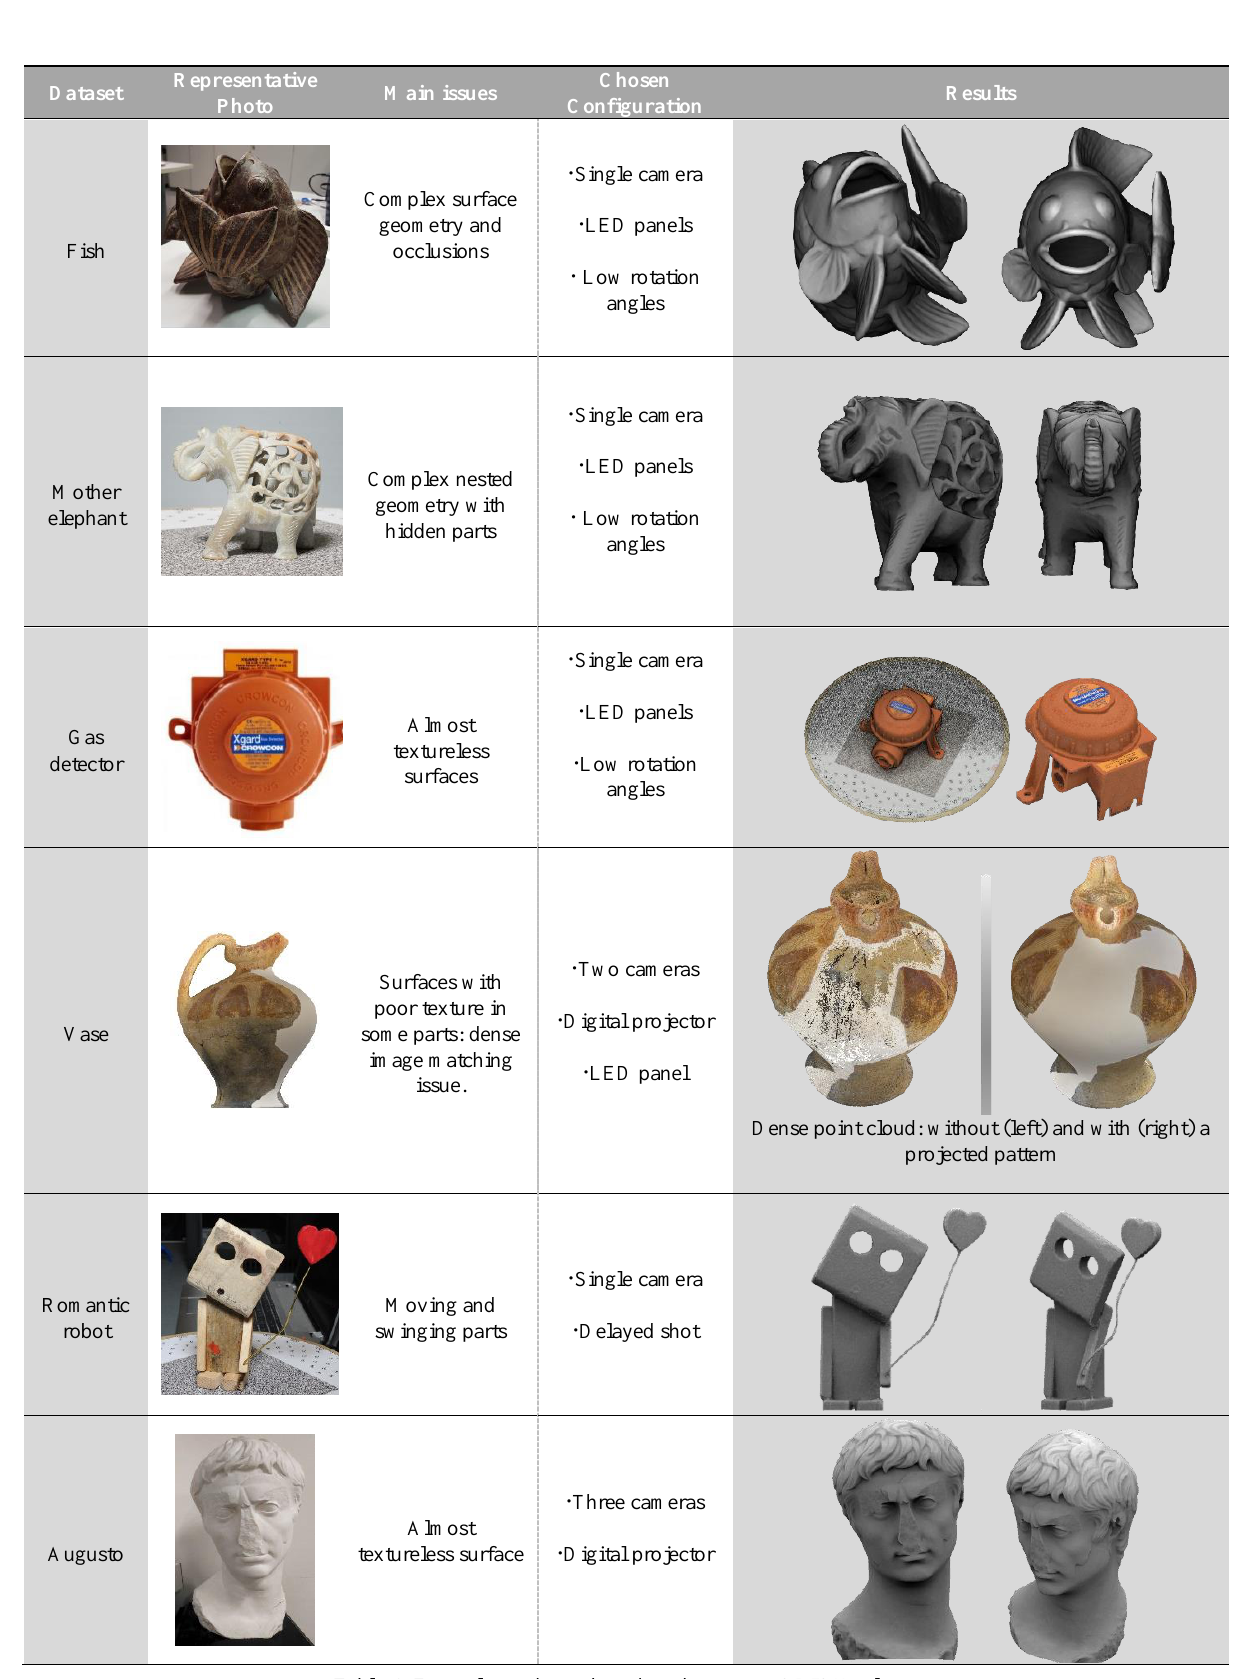
Table 4. Examples and tests based on the current ORION